Question: Summarize what this figure shows in one sentence.
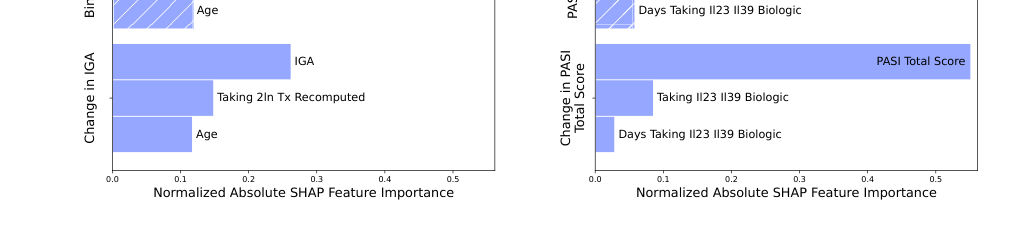
Answer: SHAP values for the Immunology & Inflammation therapeutic Area. For each patient, SHAP values for each baseline feature are first taken as absolute values, then normalized so that their sum equals one. This process is repeated for each of three important outcomes for each indication indicated in the y-axis label. Finally, these normalized SHAP values are averaged across all patients to derive the average contribution of each feature per outcome.